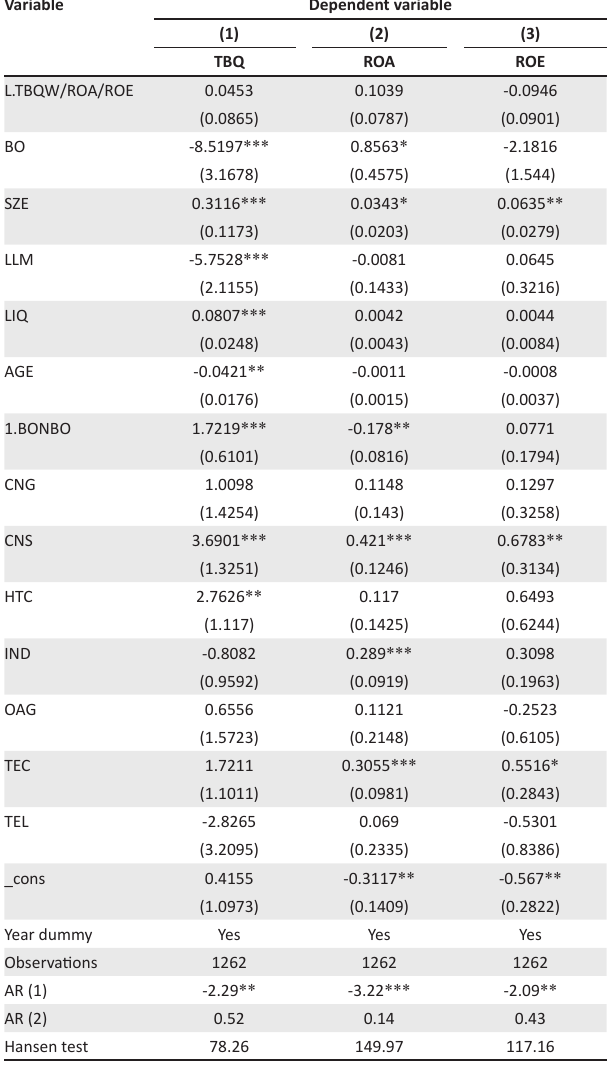
TABLE 7: The effect of black ownership on performance (generalised method of moments).